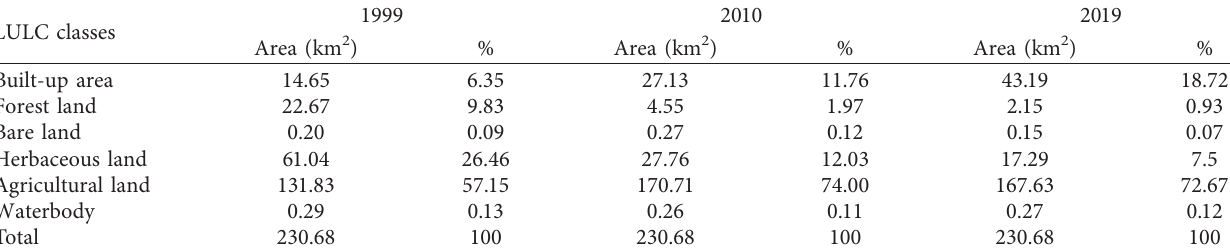
Table 4: LULC area statistics for 1999, 2010, and 2019.